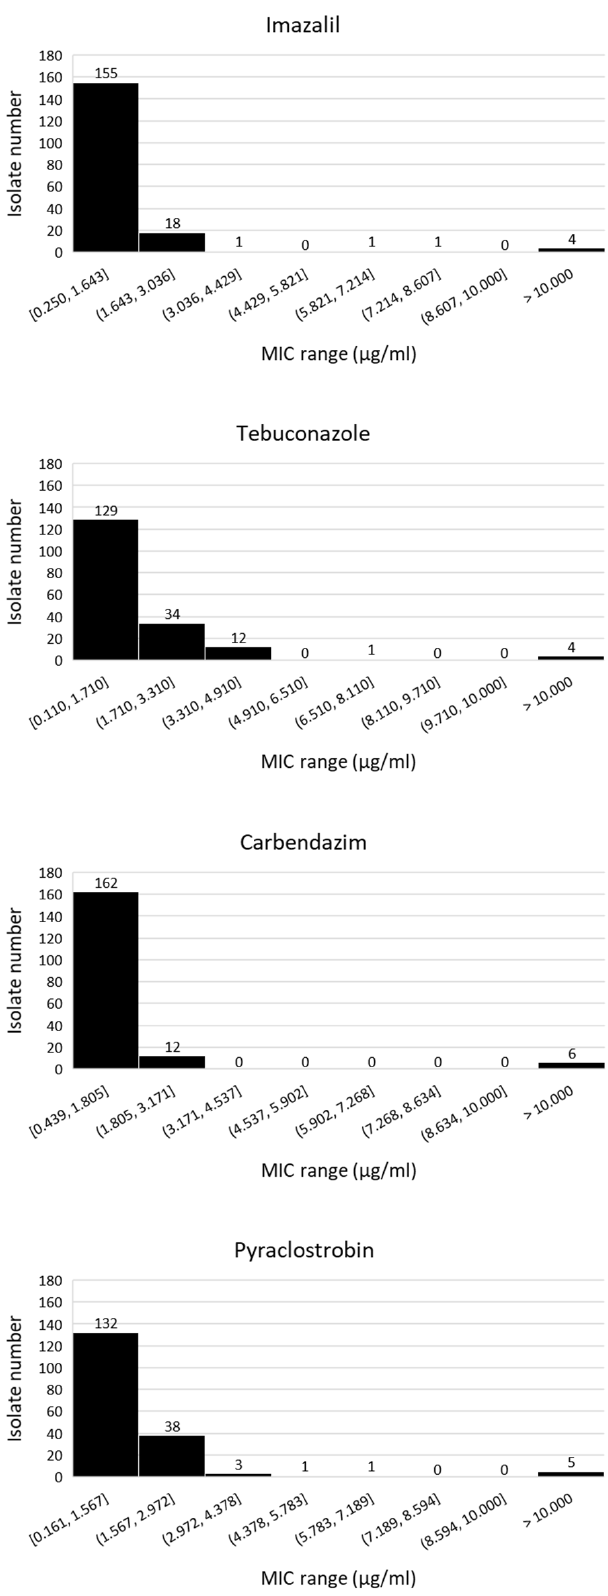
Figure 1. MIC distribution of A. fumigatus isolates sampled from tulip field soils ( n = 180) in the Netherlands. Numbers show amount (sum) of isolates within each MIC range .